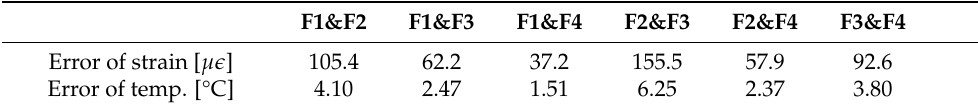
Table 5. Calculated errors when using the error propagation model.